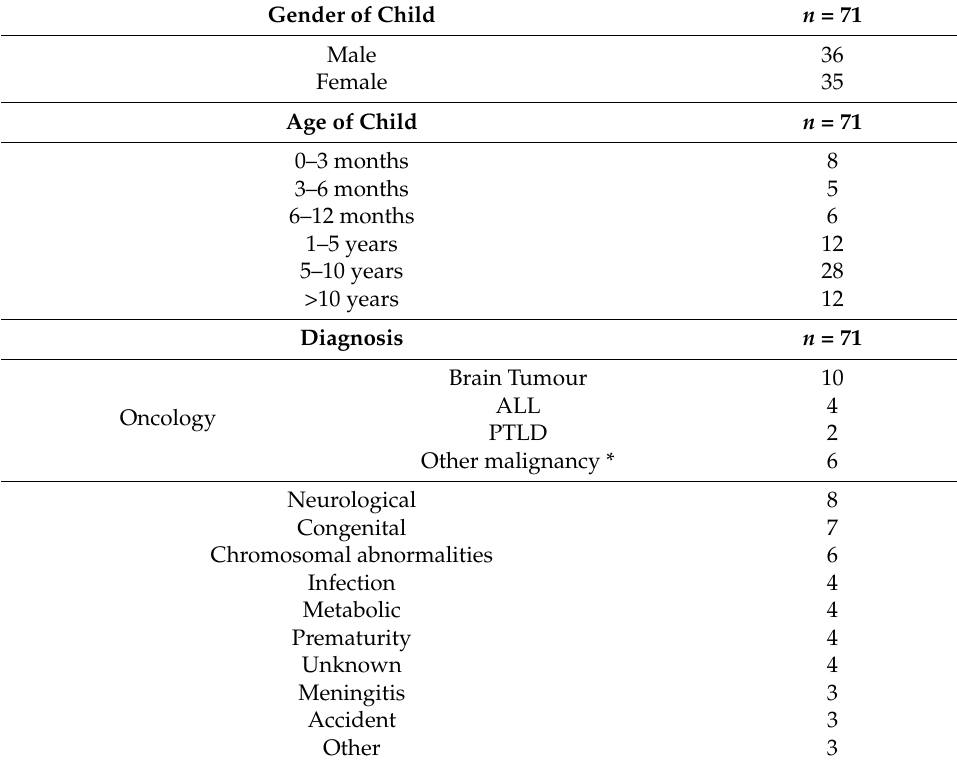
Figure 1. Medical records in which a resuscitation plan (RP) was documented. Table 1. Patient